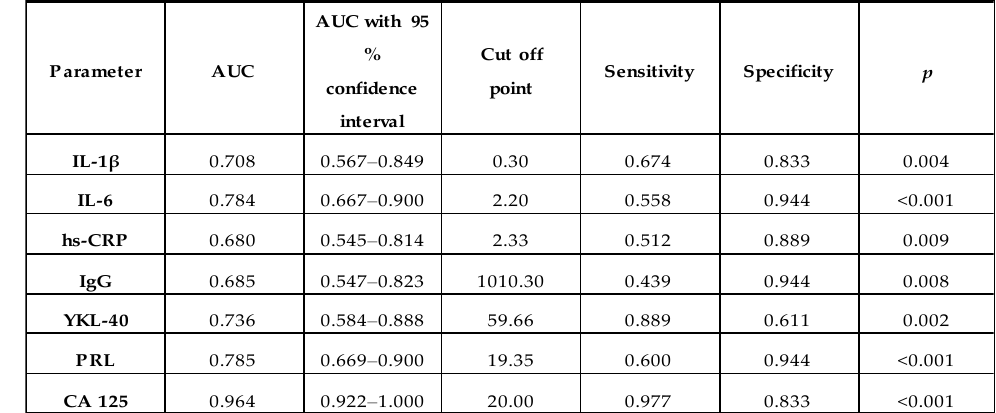
Figure 2. Receiver operating characteristic (ROC) curves for serum concentrations of IL-1 β , IL-6, hs-CRP, IgG, YKL-40, PRL and CA 125 as markers of advanced endometriosis ( A – H ). Data are given as area under the ROC curve (AUC) with a 95% confidence interval.